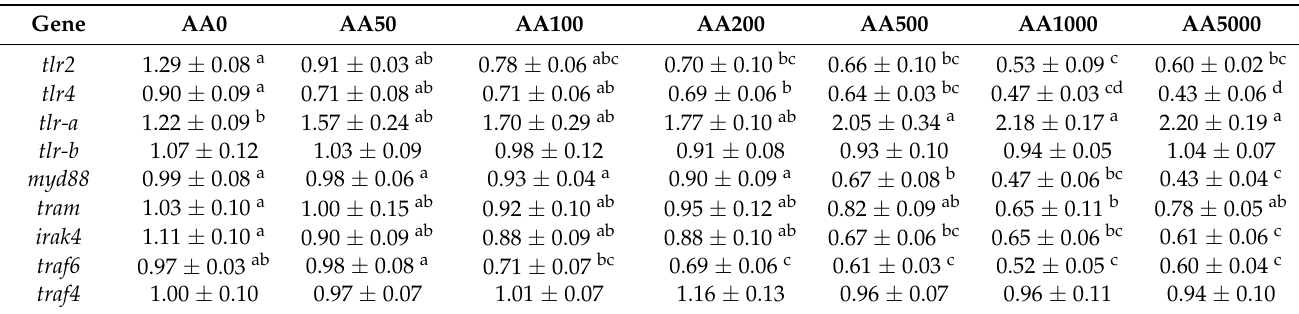
Table 6. Expression levels of tlr2 , tlr4 , tlr-a , tlr-b , myd88 , tram , irak4 , traf4 and traf6 in the digestive gland of abalone ( Haliotis discus hannai ) after a 100-day feeding trial.